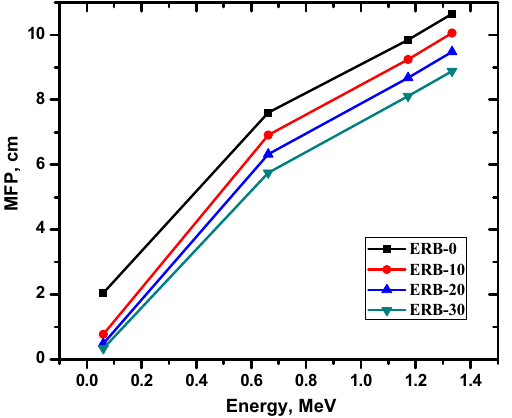
Figure 9. The mean free path for the prepared composites.